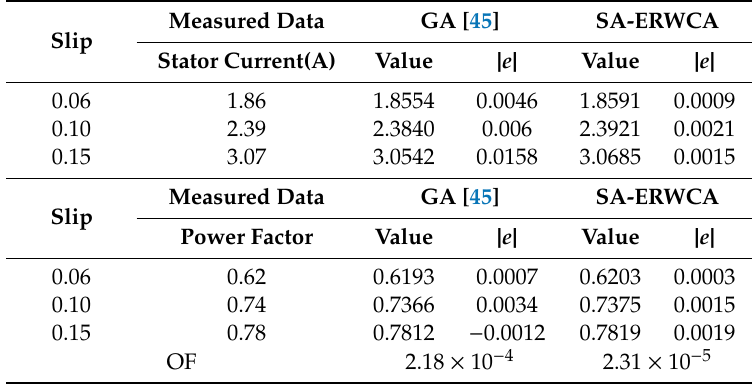
Table 19. Comparison of GA and SA-ERWCA results with measured data for Machine 4.